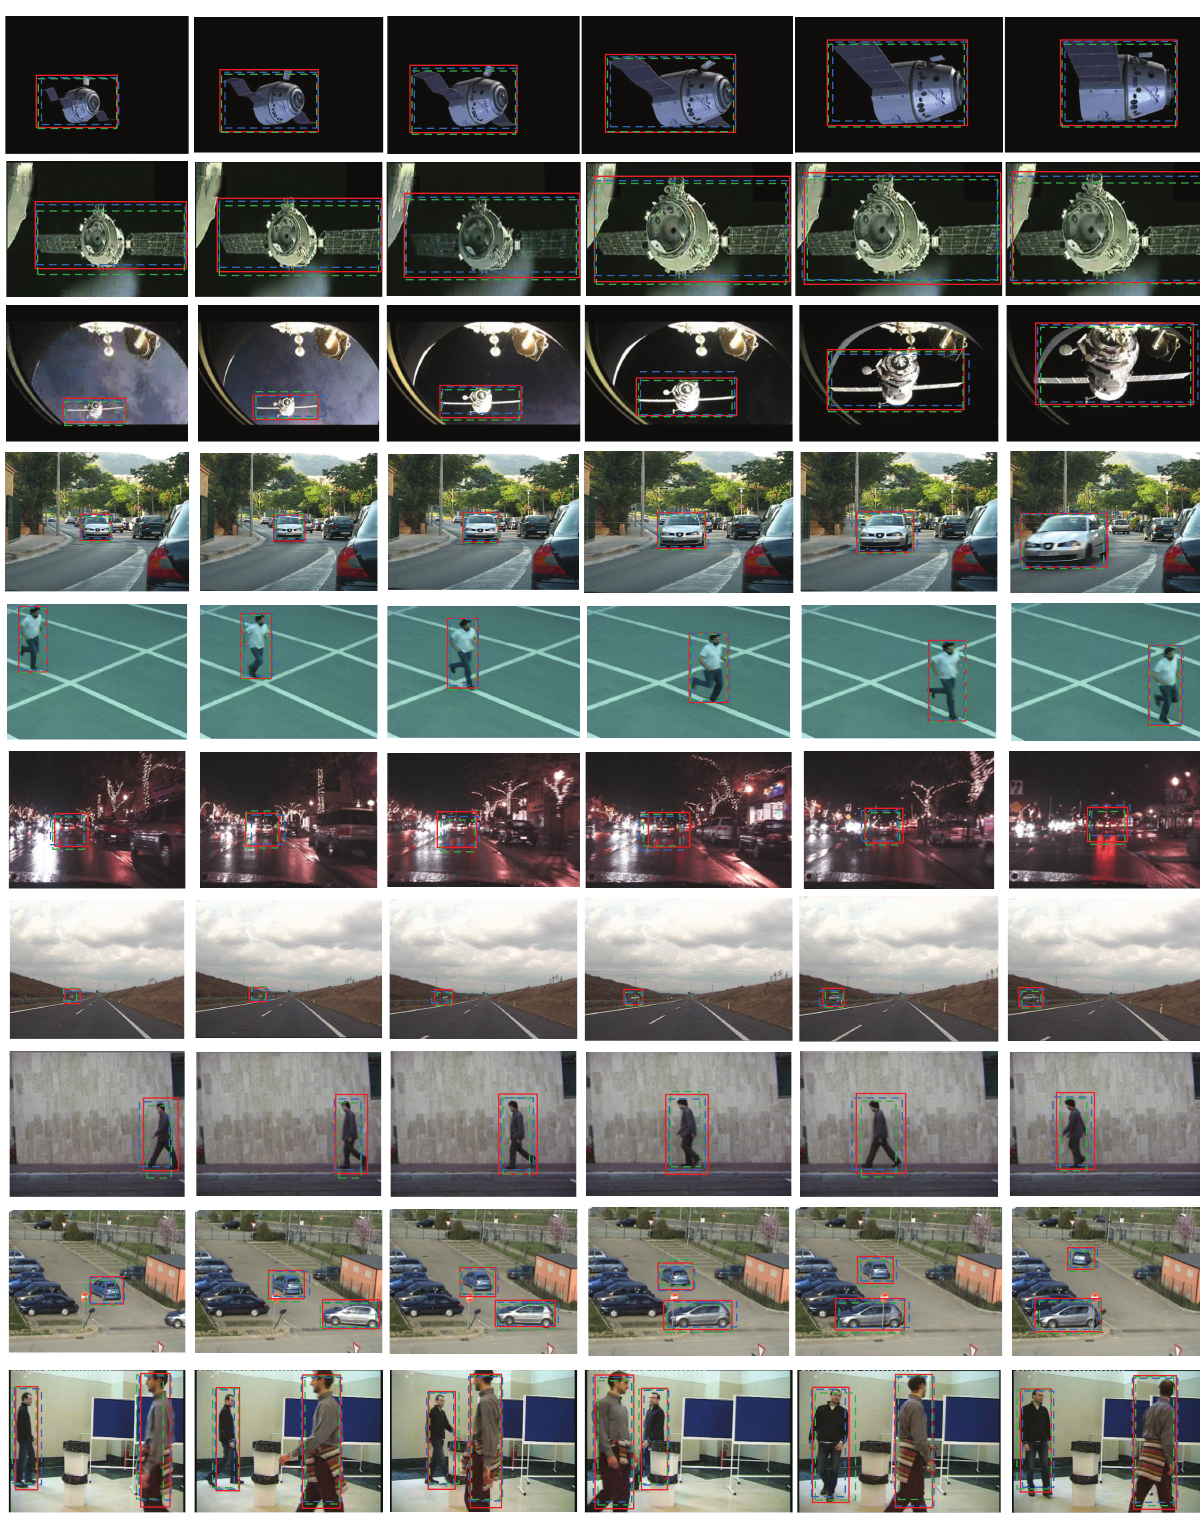
Figure 4: Experimental results from the tracking, marked by the bounding box. The red (solid line) box is from our proposed method, the blue (dashed line) box is Tracker-1 from the particle filters in [27], and the green (dashed line) box is Tracker-2 from the online distance metric learning in [28]. The rows 1–10 contain images from the videos “Satellite-1,” “Satellite-2,” “Satellite-3,” “Automobile-1,” “Running,” “Automobile- 2,” “Highway,” “Walking,” “Automobile-3” and “Walking-2,”